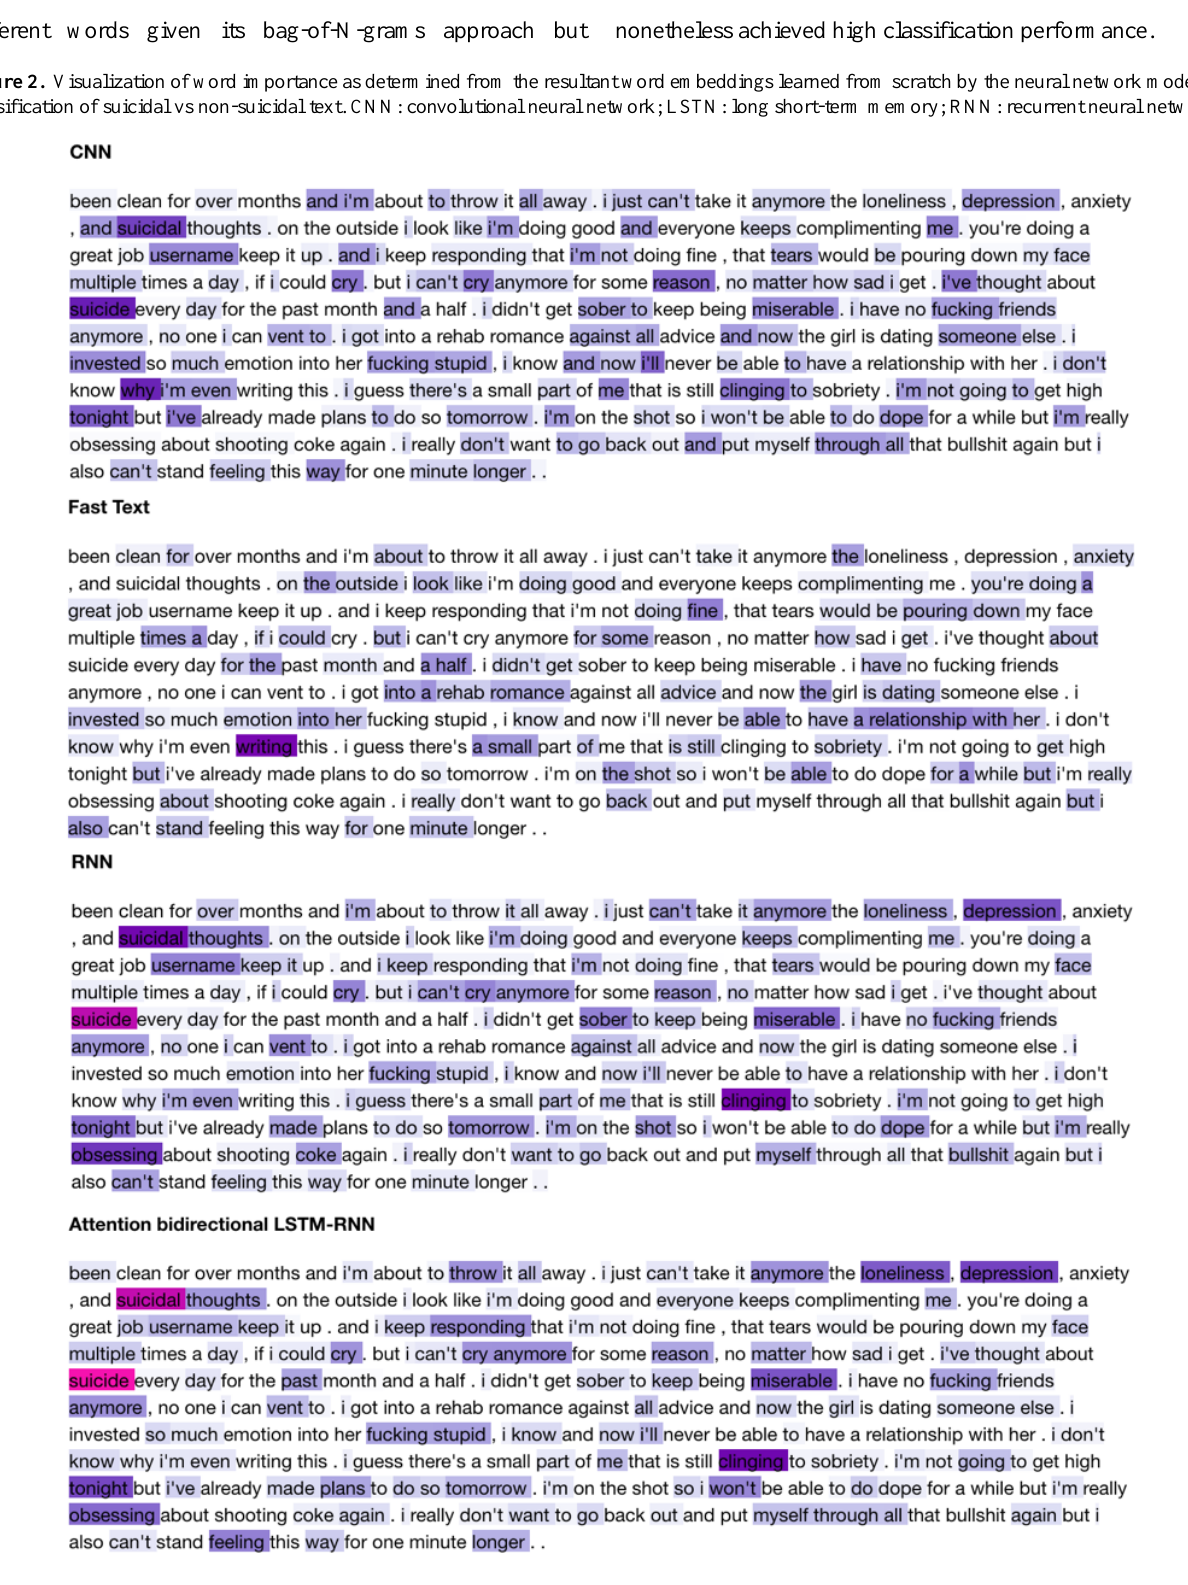
Evaluating Predictions Using MTURK